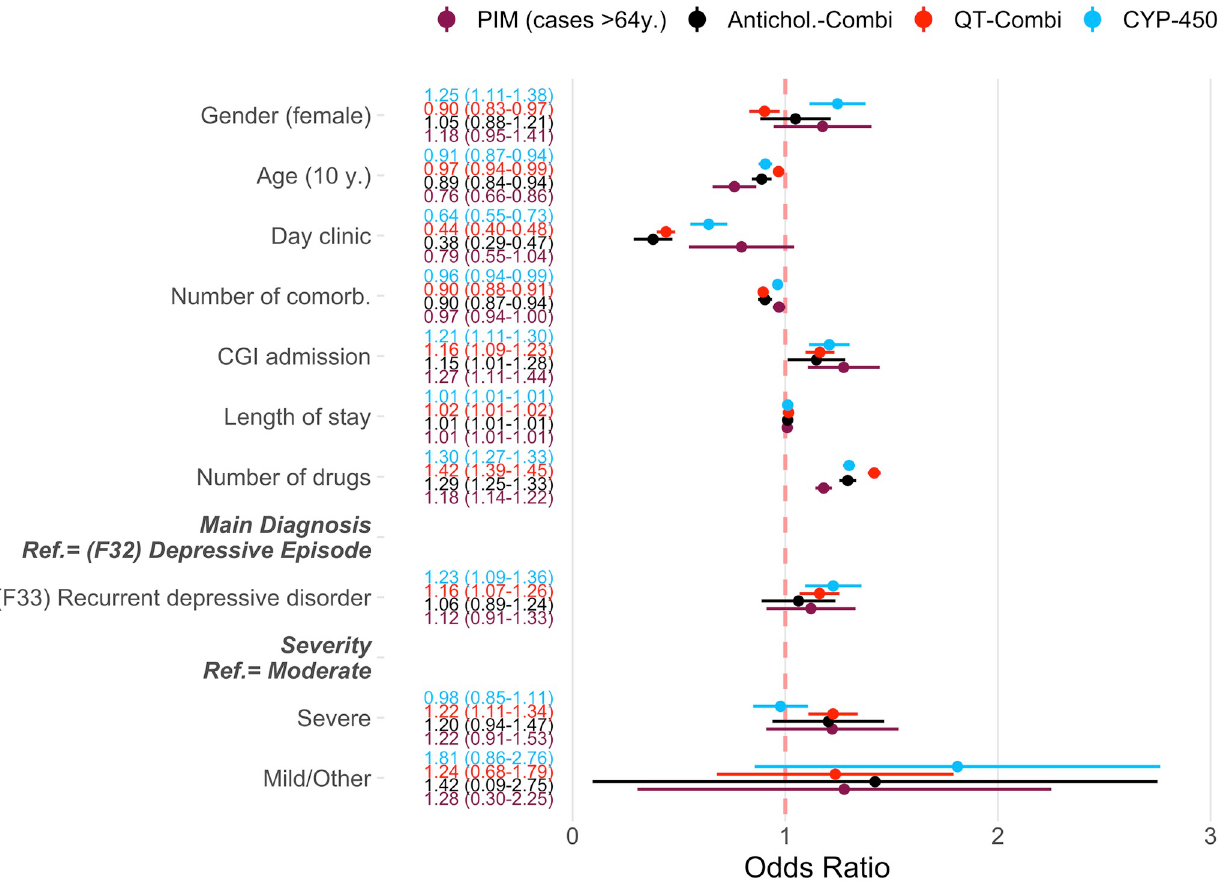
Fig 4. Patient-specific risk factors for pDDI and PIM. Circles show odds ratios of a multivariate logistic regression. These ratios reflect the multiplicative effect per influencing variable, i.e., for example, the risk of receiving at least one PIM increased by 18% for each additional drug taken, controlled for the other variables in the model. The values in brackets show the 95% confidence interval. Confidence intervals that do not include 1 show a statistically significant effect. CYP450-Interaction: Pharmacokinetic cytochrome P450 (CYP)-mediated drug-drug interaction. QT-Combi.: A combination of at least two drugs on the same day with known or possible risk of TdP. Antichol. Combi.: A combination of at least two drugs on the same day with at least moderate anticholinergic activity. PIM: Potentially inappropriate medication in the elderly. Mod.: